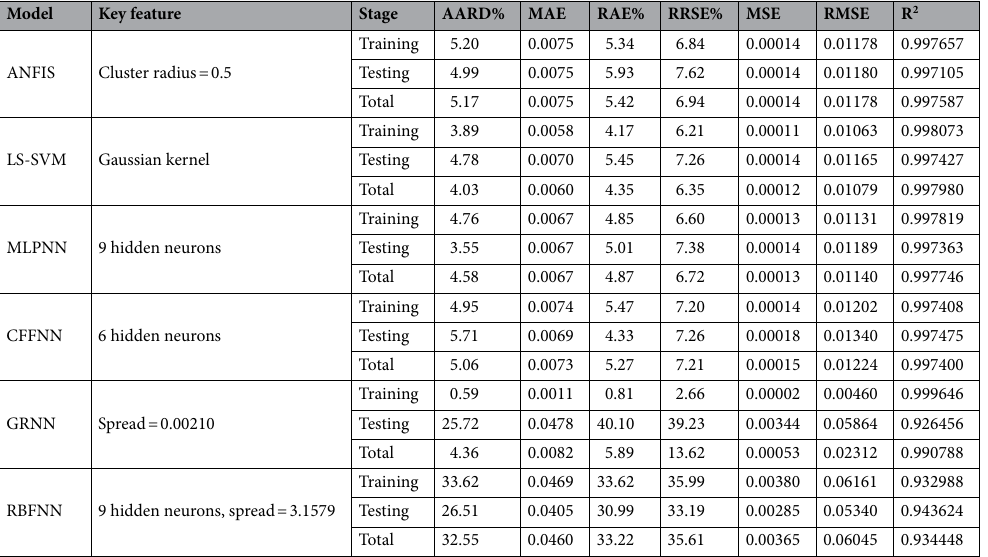
Table 4. Statistical evaluation of the best selected model in each